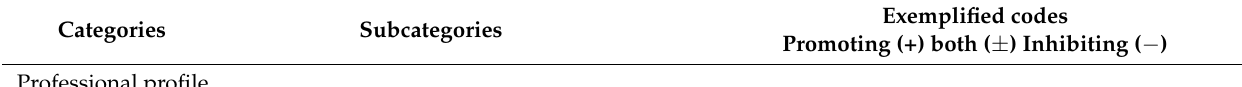
Table 2. Overview of categories, subcategories and exemplified codes indicating promoting or inhibiting factors for professional identity